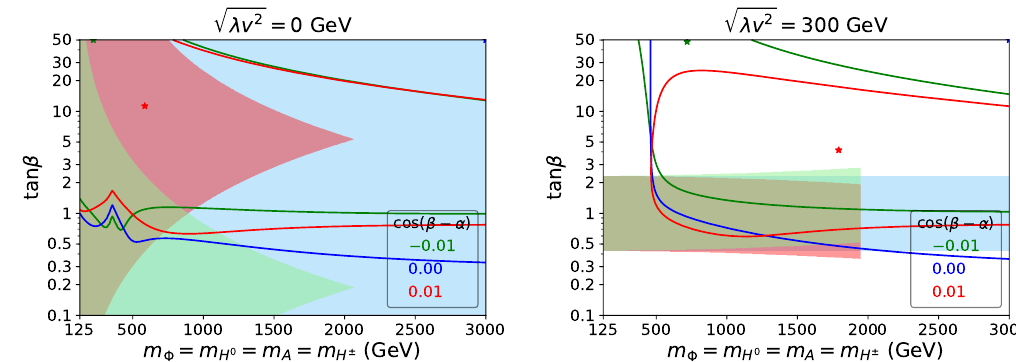
Figure 6 . Allowed region from three-parameter (cid:12)tting results at 95% C.L. in the m (cid:8) (cid:11) ) under CEPC precision for p (cid:21)v 2 = 0 GeV (left panel) and 300 GeV (right with varying cos( (cid:12) (cid:0) panel) for degenerate mass case. Green, blue and red curves (stars) represent the constraints (best (cid:11) ) = (cid:12)t point) for cos( (cid:12) 0 : 01 ; 0 ; 0 : 01 respectively. The theoretical allowed region are also (cid:0) (cid:0) shown in shaded region with the same color.